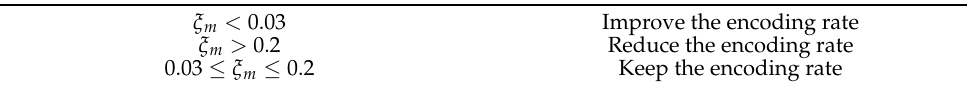
Table 2. Threshold setting of mean aggregation degree ξ m after one iteration for Yellow Sea 1 and Yellow Sea 2.